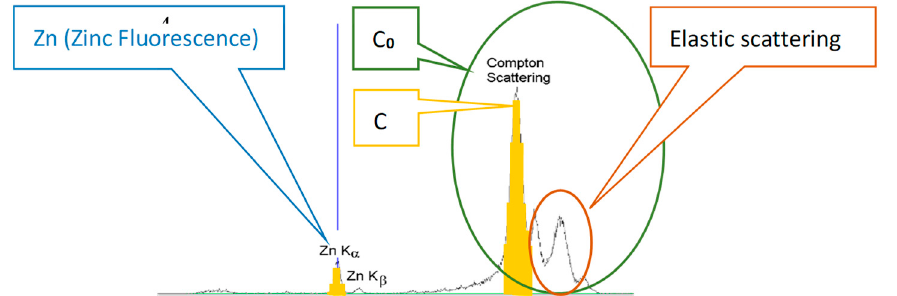
Figure 1. Zn and scattering counts.